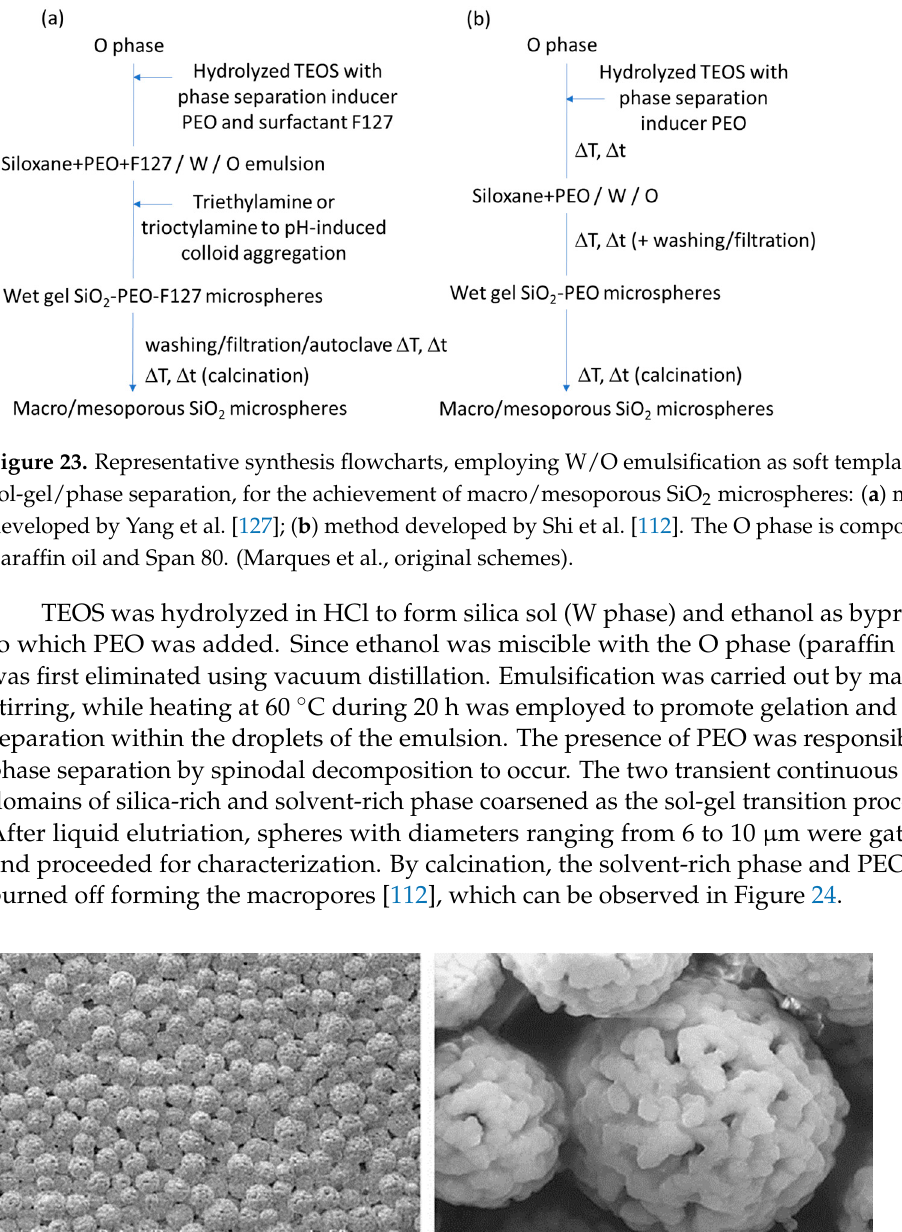
Consequently, the surface area decreased by 33%, but the pore volume increased by